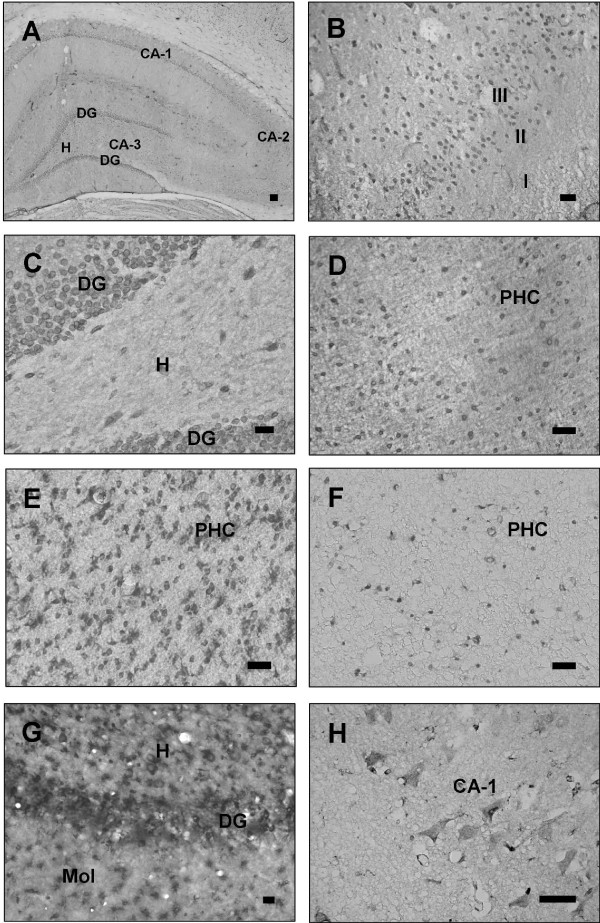
Micrographs showing expression of the transcription factor YB-1 in the rat, macaque and human brain (A-H). (A) Image displaying hippocampal YB-1 expression visualized by a DAB-staining method in a 14 μm thin section of an adult rat's hippocampus (DG = dentate gyrus, H = hilus of the dentate gyrus, CA = cornu ammonis formation). (B) Representative example of YB-1 expression in the piriform cortex (layer I-III) of an adult rat. Note, that the expression of YB-1 is predominantly related to cells in the layer III of the piriform cortex. (C) Image showing YB-1 expressing granule cells of the dentate gyrus and YB-1 expressing cells in the hilar (H) subregion of the hippocampus of an adult rat. (D) Image displaying YB-1 expression visualized by a DAB-staining method in a 14 μm thick section of the parahippocampal cortex (PHC) of a rat. YB-1 expression appears throughout all layers of the cortex. (E) Image displaying YB-1 expression visualized by a DAB-staining method in a 40 μm thick section of a macaque's parahippocampal cortex (PHC). In this image YB-1 appears to be stronger expressed as in the rat's brain due to the relative thickness of this section in comparison to the thinner sections of the rat. (F) Image displaying YB-1 expression visualized by a DAB-staining method in a 3 μm thin section of a human parahippocampal cortex (PHC). Due to the section thickness of only 3 μm, YB-1 appears to be less expressed compared to images of the rat's and macaque's brain. (G) Image displaying YB-1 expressing granule cells of the dentate gyrus (DG) as well as YB-1 expressing cells in the hilar (H) subregion and the molecular layer (Mol) of the hippocampal formation in the brain of a macaque. (H) YB-1 expression in the hippocampal CA-1 region of the human brain. A: scale bar = 100 μm. B-H: scale bar = 20 μm.